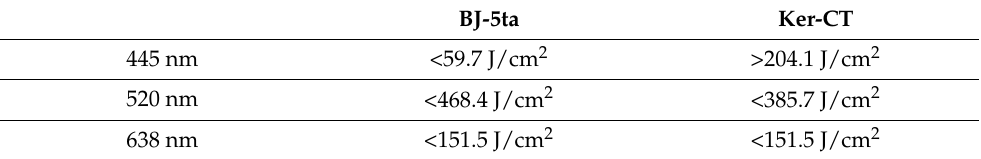
Table 1. Safe fluences of 445 nm, 520 nm, and 638 nm irradiation for Ker-CT keratinocytes and